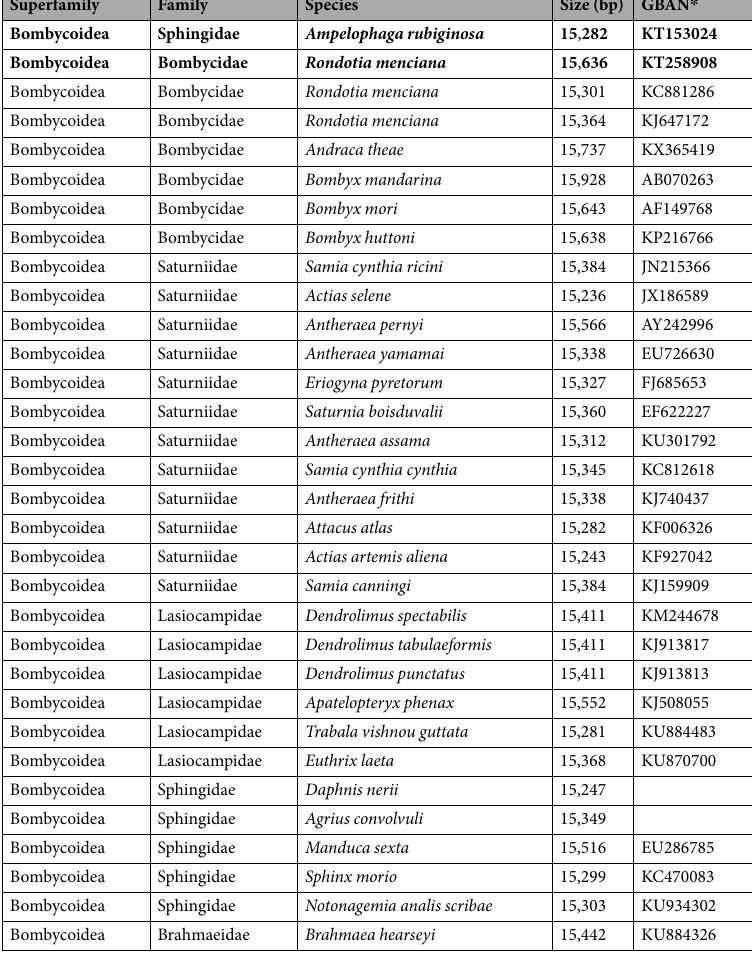
Table 1. List of Bombycoidea species analysed in this paper with their respective GenBank accession numbers. * GenBank accession number.